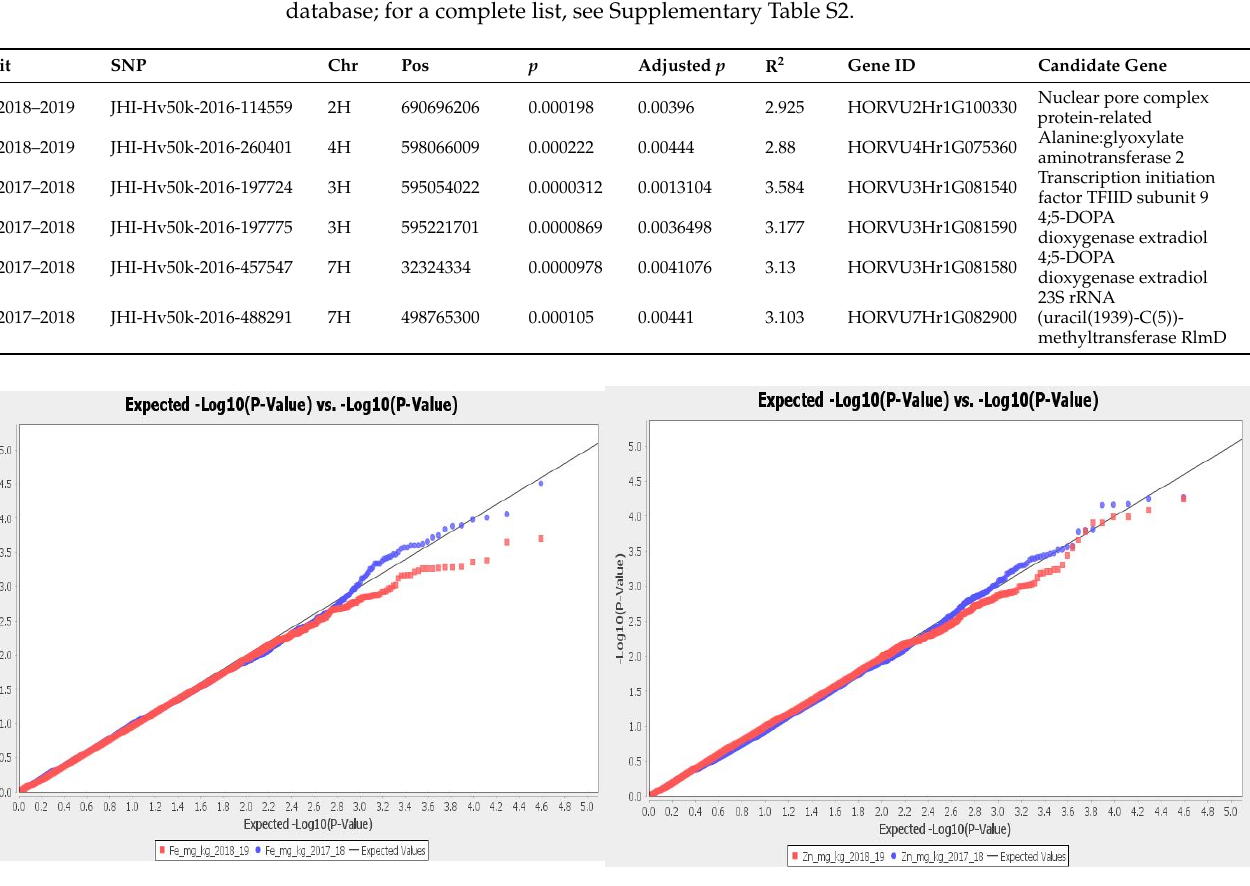
Figure 5. Quantile-quantile (Q-Q) plots for Fe ( left ) and Zn ( right ). Table 2. Annotation of significant SNPs associated with Zn using BARLEX, BarleyVarDB and Bar- leymap database; for a complete list, see Supplement Table S3.